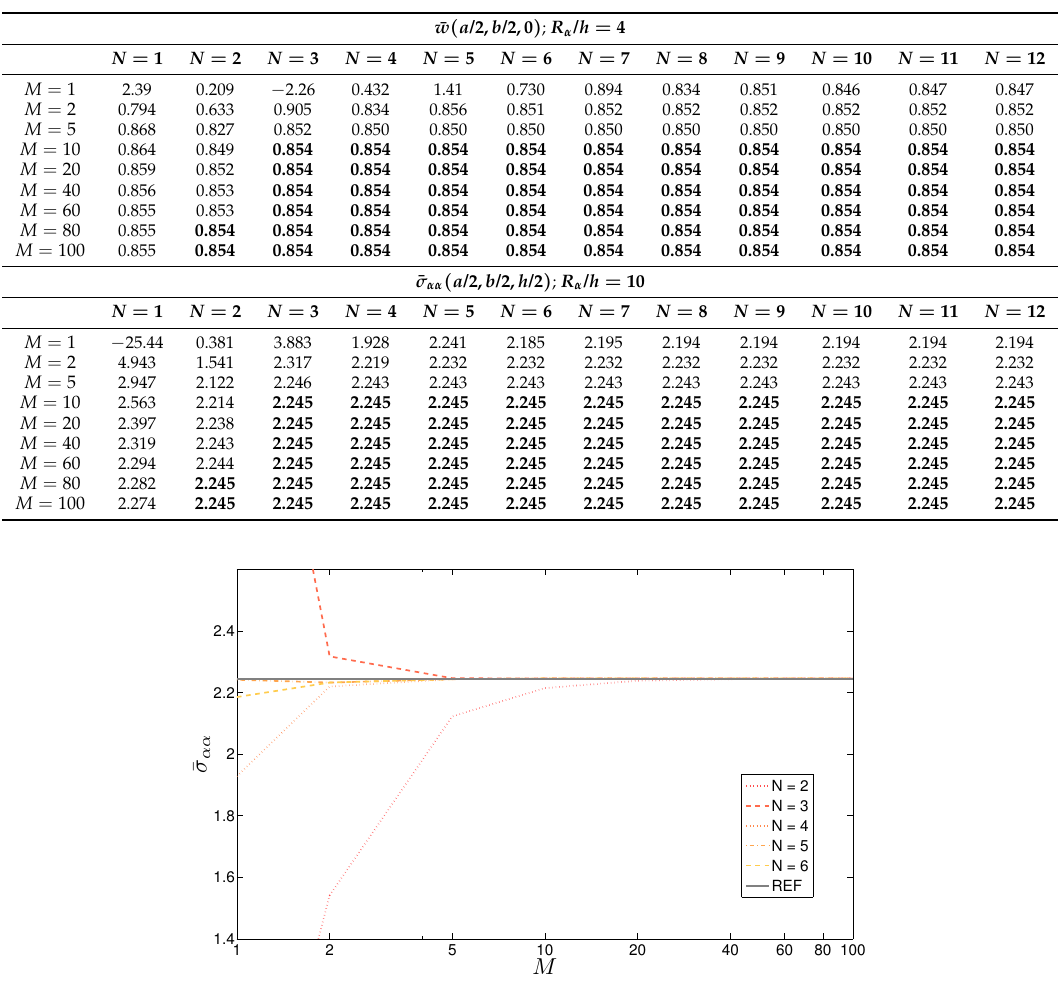
Figure 5 for the stress ¯ σ αα with a progressive increase of the order of expansion for the exponential matrix until N = 6. Table 4. Case 2. Composite laminated cylindrical shell. Displacement ¯ w for thickness ratio R α / h = 4 evaluated in the middle and stress ¯ σ αα for thickness ratio R α / h = 10 evaluated at the top, both given as dimensionless values. Each physical layer ( N L = 2) is divided into M mathematical layers. 3D reference solution by Ren [34].